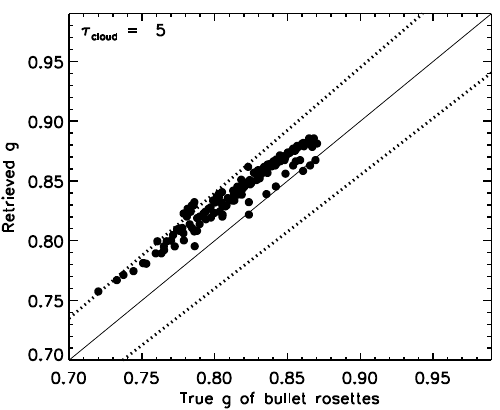
Fig. 4. Asymmetry parameters of bullet rosettes versus the asymme- try parameters retrieved with the proposed method from simulated data with a cloud optical thickness of 5. The solid line shows the 1-1 line. Dotted lines indicate the targeted 5% accuracy limits.